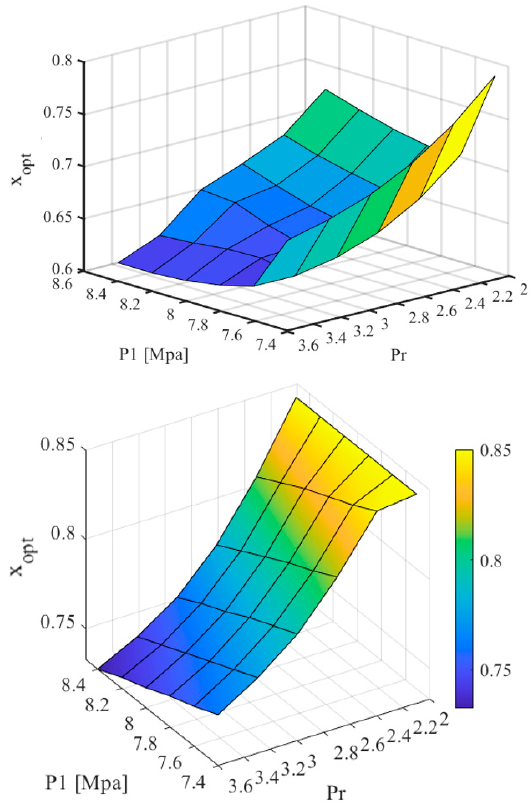
Figure 11. Variation of the optimized x with compressor inlet pressure and cycle overall pressure ratio. Error! Reference source not found. shows the variation in (cid:2015) (cid:3030)(cid:3052)(cid:3030) with compressor in- let temperature ((cid:1846) (cid:2869) ) and cycle overall pressure ratio ((cid:1842)(cid:1870)) . It dictates that the cycle’s effi- ciency was quite sensitive to the pressure ratio for all values of the compressor’s inlet temperature ((cid:1846) (cid:2869) ) . However, its sensitivity to the pressure ratio was more prominent when the compressor’s inlet temperature was close to the critical temperature value of (cid:1829)(cid:1841) (cid:2870) . For all values of (cid:1846) (cid:2869) , (cid:2015) (cid:3030)(cid:3052)(cid:3030) increased initially and reached a maximum value before dropping with a further increase in the value of (cid:1842)(cid:1870) . Thus, there exists an optimized value of the (cid:1842)(cid:1870) corresponding to each value of (cid:1846) (cid:2869) that shifted toward the lower value of (cid:1842)(cid:1870) at higher values of (cid:1846) (cid:2869) . On the other hand, (cid:2015) (cid:3030)(cid:3052)(cid:3030) was significantly affected by the value of (cid:1846) (cid:2869) . At any fixed value of (cid:1870) , (cid:2015) (cid:3030)(cid:3052)(cid:3030) declined with the growth in the value of (cid:1846) (cid:2869) . It can be seen that (cid:2015) (cid:3030)(cid:3052)(cid:3030) was sensitive to compressor inlet temperature escalations with a rise in (cid:1842)(cid:1870) . Moreover, the cycle’s efficiency was significantly higher when the compressor’s inlet temperature was close to the critical temperature (cid:1846) (cid:3030) that decreased rapidly as (cid:1846) (cid:2869) moved away from (cid:1846) (cid:3030) Error! Reference source not found. represents a response surface bounded by (cid:1846) (cid:2869) and (cid:1842)(cid:1870) . It shows that (cid:1876) (cid:3042)(cid:3043)(cid:3047) was influenced by both the compressor inlet temperature and the cycle pressure ratio. The value of (cid:1876) (cid:3042)(cid:3043)(cid:3047) decreased initially and then, after a certain pressure ratio for which its value was minimum, it started increasing. On the other hand, the value of (cid:1876) (cid:3042)(cid:3043)(cid:3047) increased rapidly as the compressor inlet temperature moved away from (cid:1846) (cid:3030) ; how- ever, at higher values of (cid:1846) (cid:2869) , the rate of increase in the value of (cid:1876) (cid:3042)(cid:3043)(cid:3047) became smaller. Thus, it can be depicted from here that selection of (cid:1846) (cid:2869) is crucial for the main and re-compressor sizes.